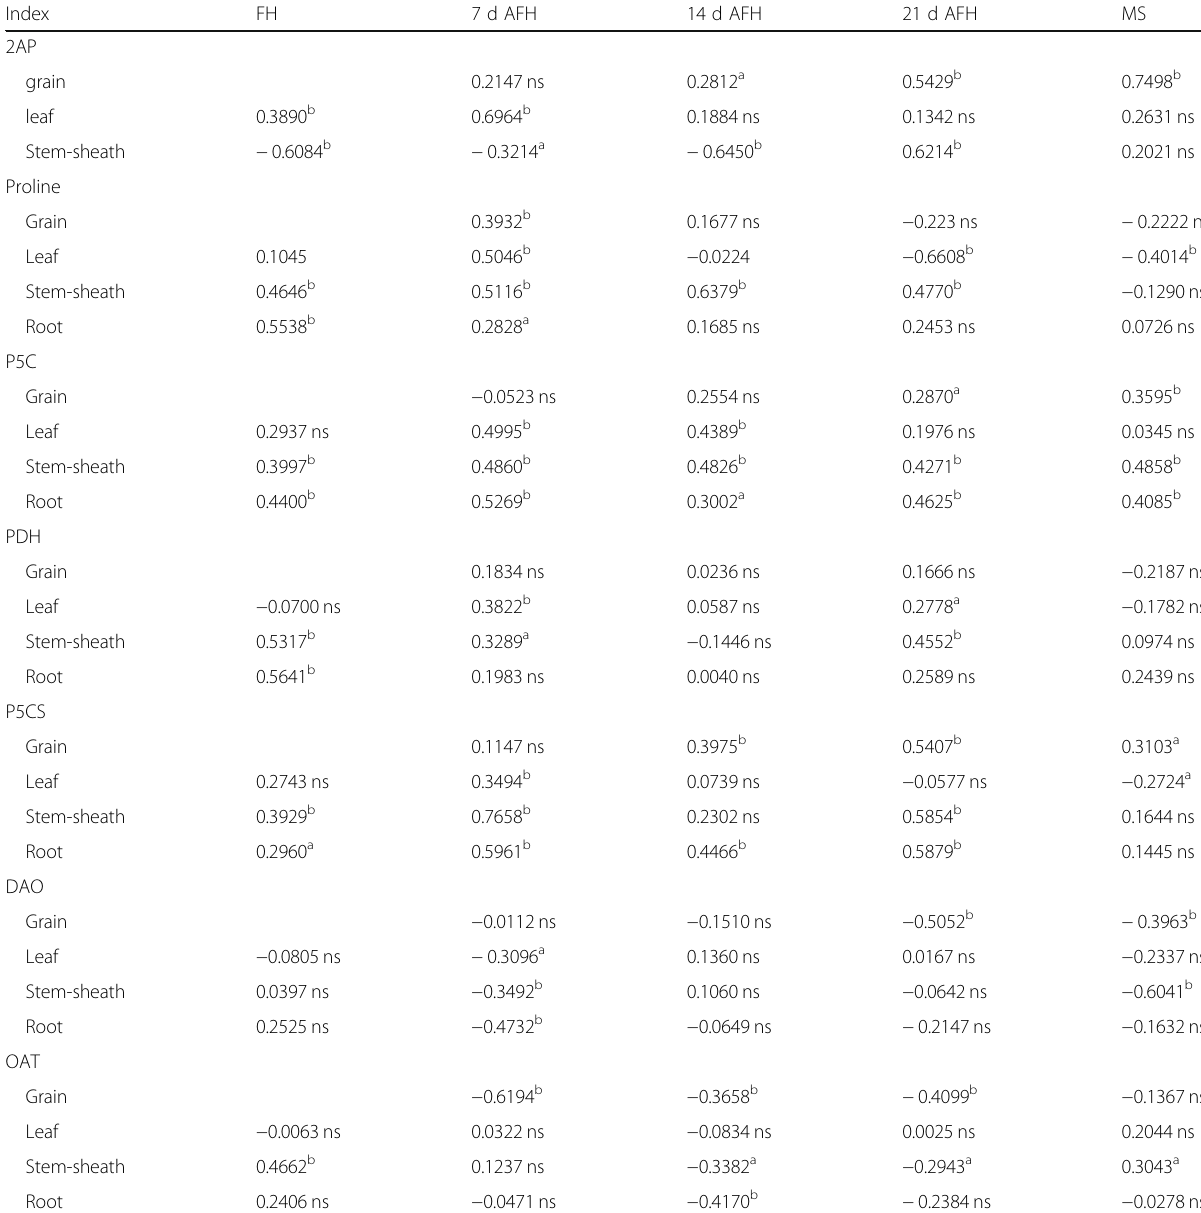
Table 5 Correlation analyses between 2AP content in brown rice and the investigated